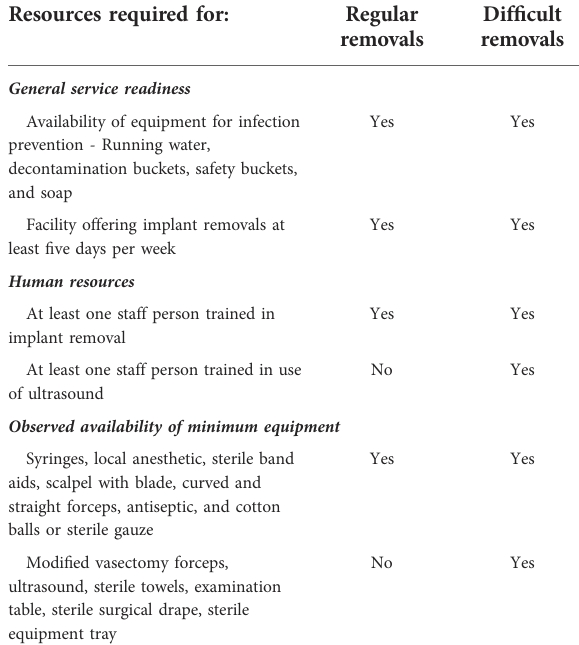
TABLE 1 Components of readiness assessment to handle regular and dif fi cult removals. Resources required